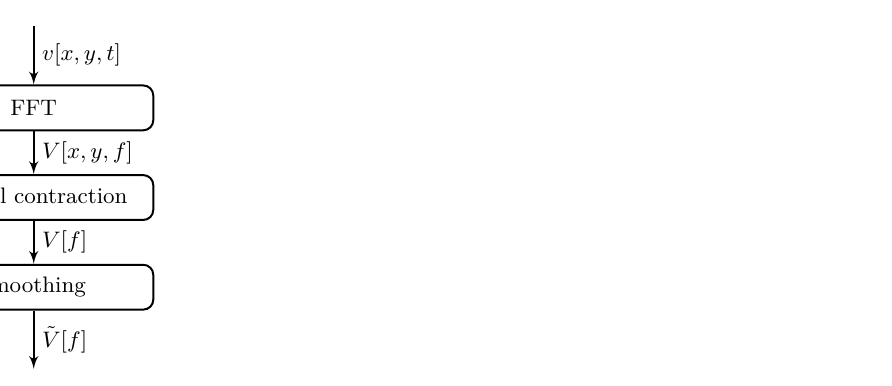
Figure 7. Flow chart showing the steps necessary to obtain the velocity spectra from the LDV data.